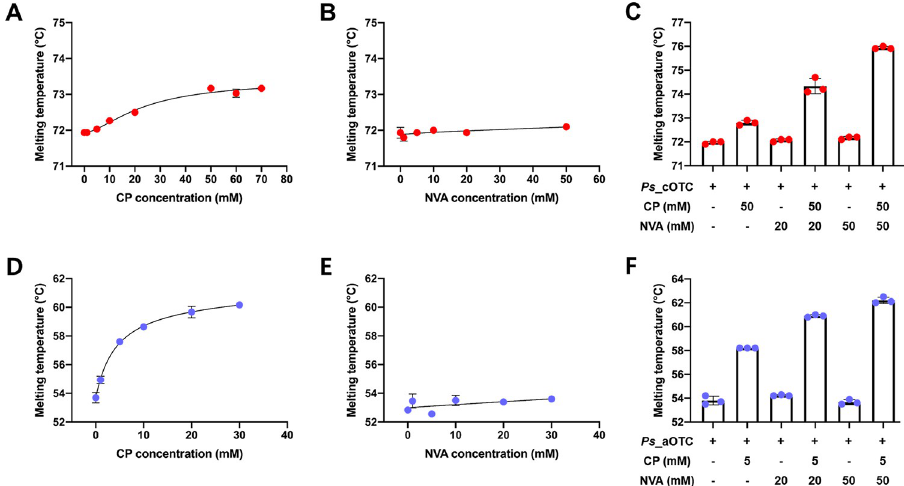
Fig 2. Thermal stability of Ps _cOTC (A, B, C) and Ps _aOTC (D, E, F) with various concentration of CP and NVA. The stability of OTC was measured in 20 mM Tris-HCl (pH = 8.0) after 15 min of incubation at 295K. The melting temperature is determined by the inflection point of the curve. The data are representative of three individual experiments.